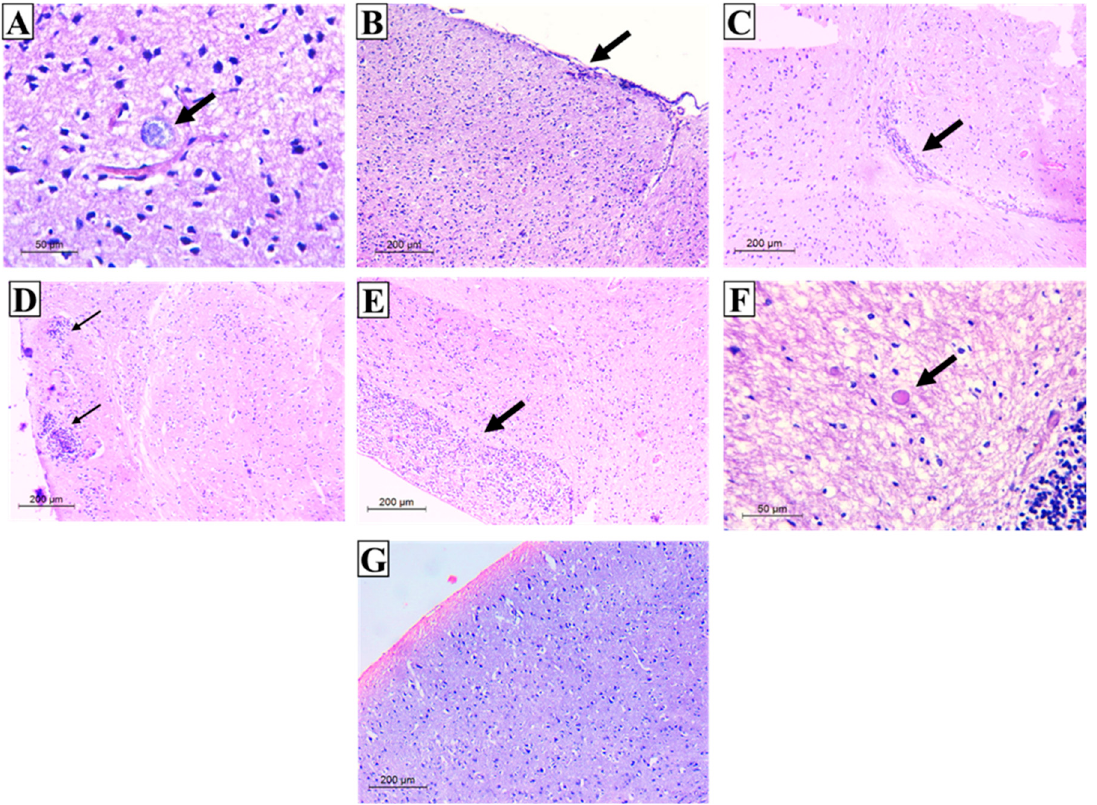
Figure 11. Histopathological findings in brain sections of the infected control group ( A – E ), and vac- cinated groups ( F , G ). ( A ) H&E-stained section showing an oval, well-defined T. gondii cyst in the cerebral cortex containing multiple bradyzoites (×400), ( B ) H&E-stained section showing severe in- flammatory infiltration of meninges on the surface of the cerebral cortex (×100), ( C ) H&E-stained section showing perivascular lymphocytic inflammatory infiltrate (×100), ( D ) H&E-stained section showing microglial nodules (×100), ( E ) H&E-stained section showing increased cellularity through- out the brain parenchyma (×100), ( F ) H&E-stained section showing cysts with a degenerated irreg- ular cyst wall in the cerebral cortex (×400), ( G ) H&E-stained section showing an improvement in inflammatory changes with neither meningeal infiltration nor cerebral-increased cellularity (×100).